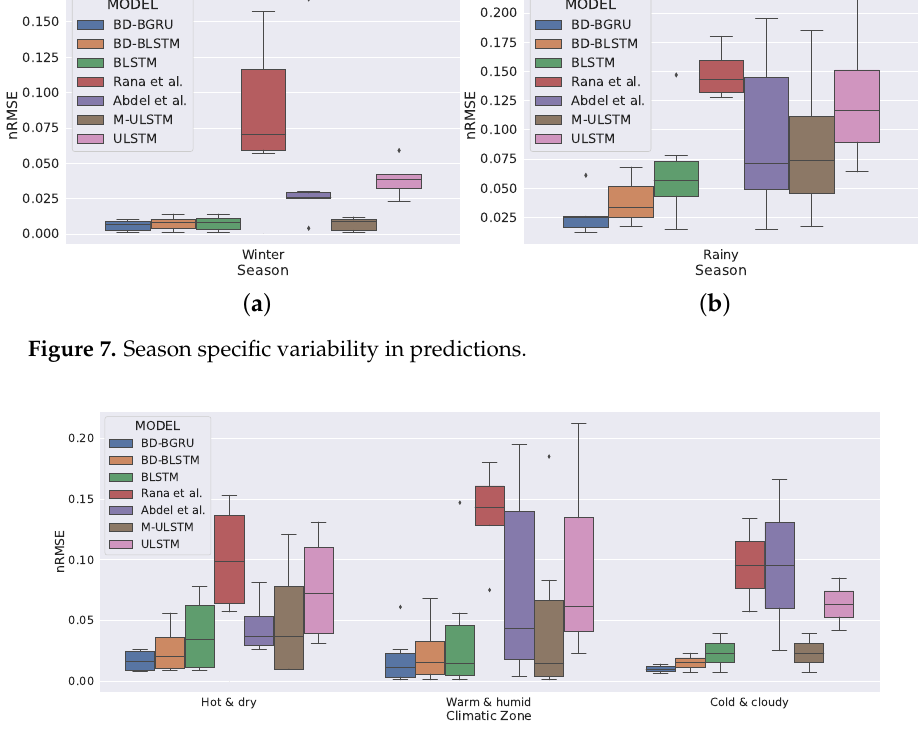
Figure 8. Climatic-zone specific variability in predictions.